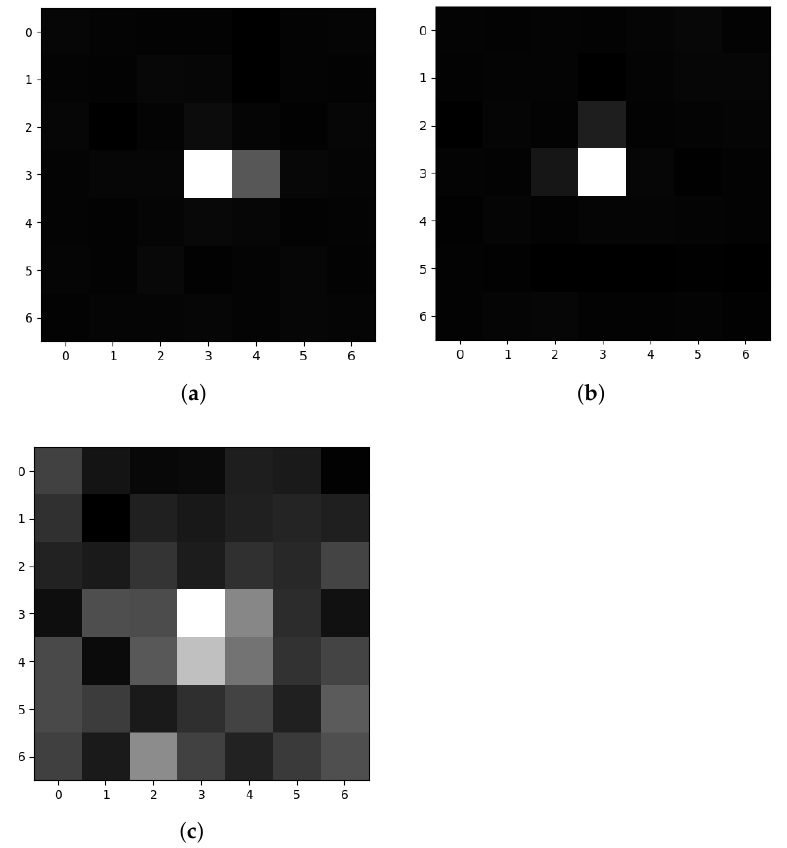
Figure 1. Examples of raw macro images. ( a ) Synthetic; ( b ) Simulated [24]; ( c ) Real [10]. The synthetic macro generator (SMG) uses the Monte Carlo method to iterate over pre- dictable parameters such as position, brightness, angular size, angular velocity, and back- ground noise. The SMG bins the data based on image resolution, pixel bit